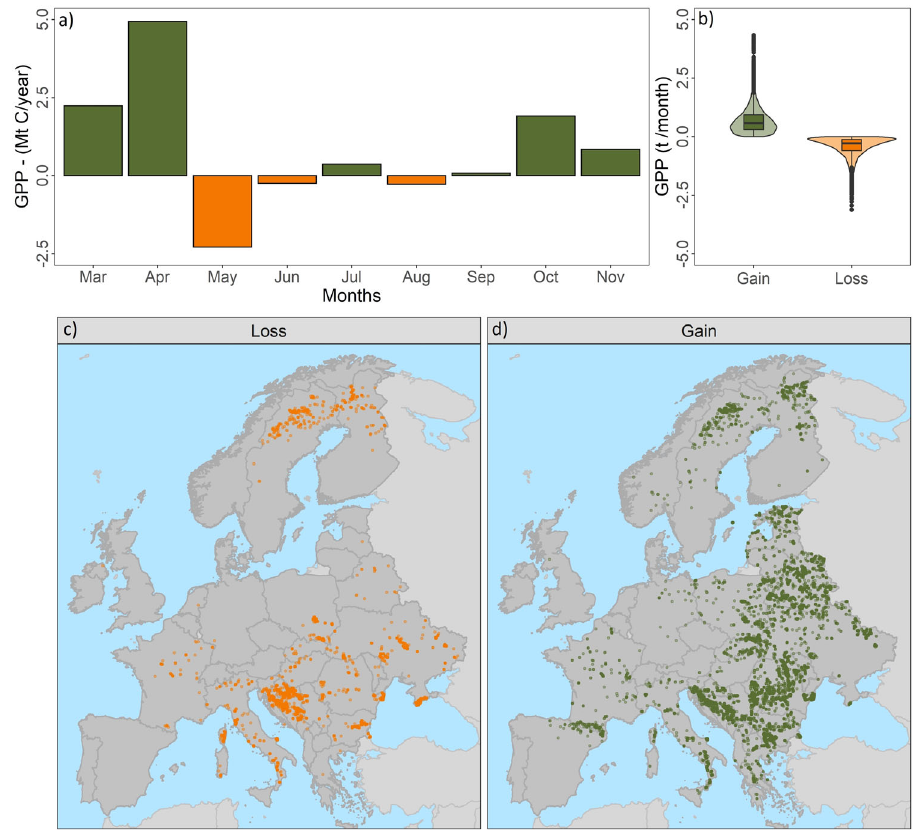
Fig. 6 Temporal and spatial gross primary production balance of forest core areas. a Gross primary production (GPP) compensation (total increase minus total decrease) for forest core areas (FCAs) at a monthly time step. b Boxplots of the annual net GPP gain and loss for all FCAs across Europe, where the black horizontal lines are the medias, and the shaded area is the frequency of the values. c Spatial distribution of FCAs with annual net GPP loss. d Spatial distribution of FCAs with annual net GPP